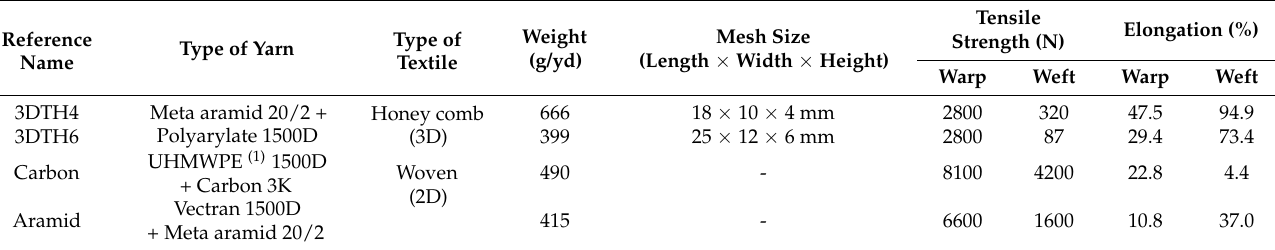
Table 1. Mechanical properties of selected textiles (KS K 0521).